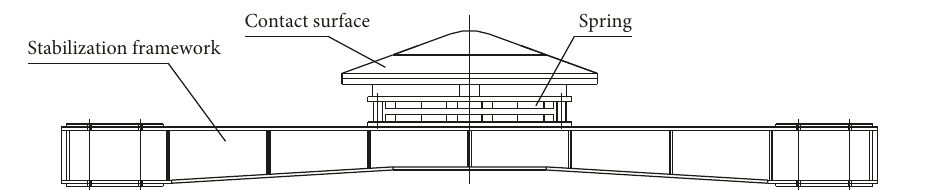
Figure 2: Diagram of the buffering device structure.